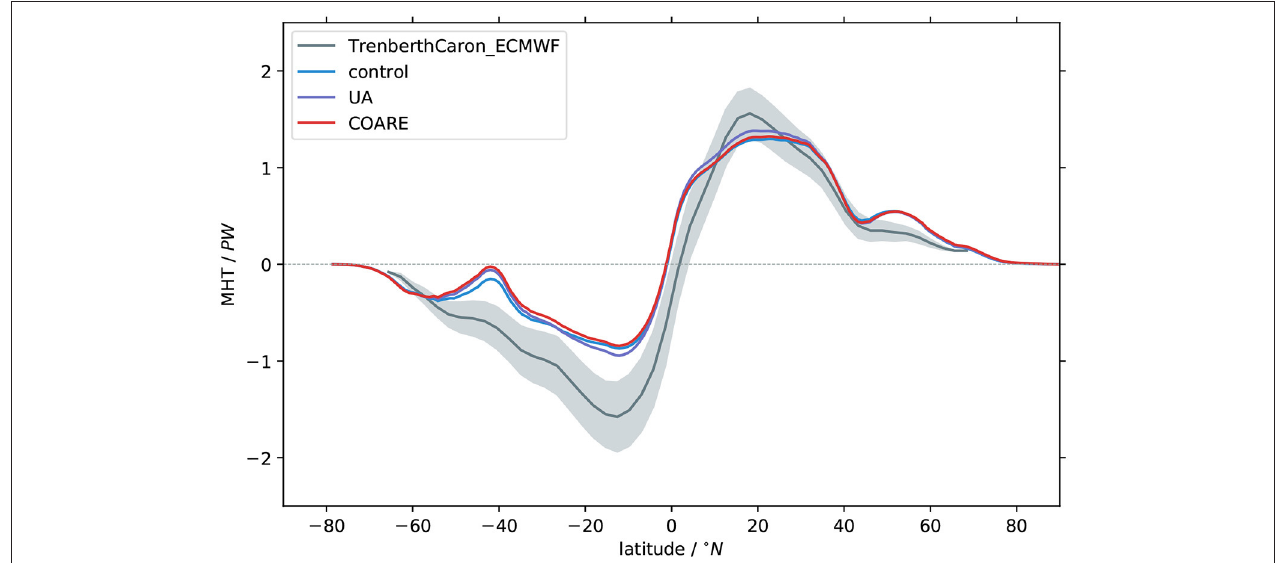
algorithm design (e.g., the functional forms of stability and roughness formulae) while at the same time revealing